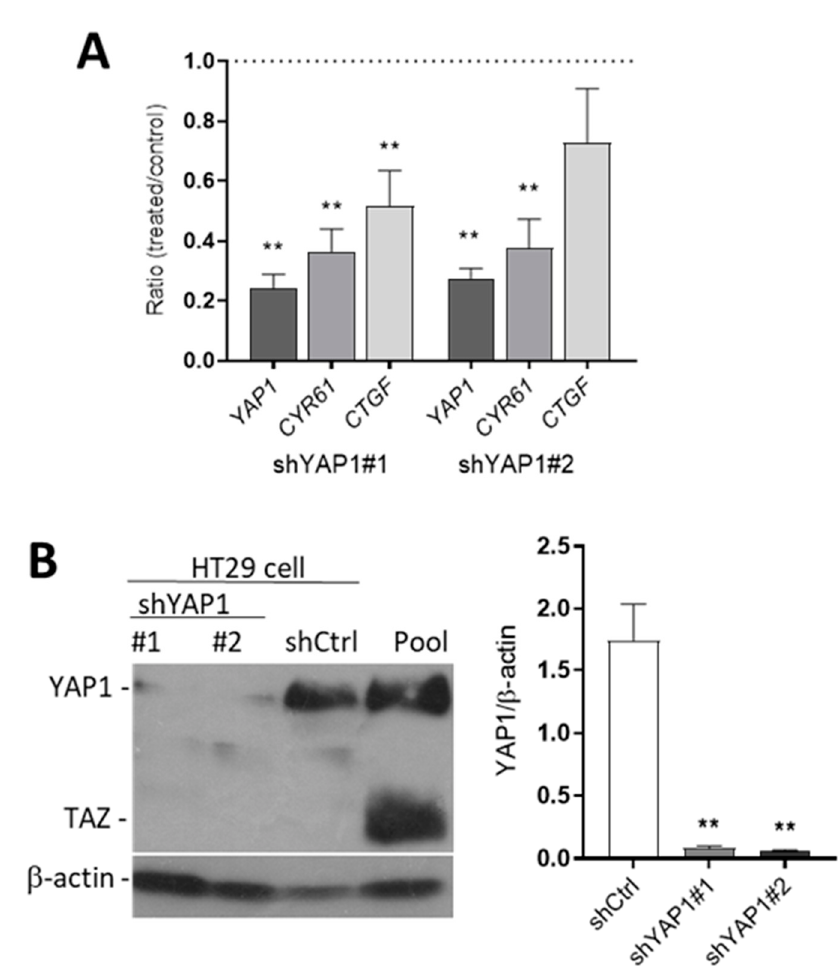
Figure 3. Efficiency of YAP1 knockdown in HT29 cells. ( A ) qPCR analyses were performed to detect the expression of YAP1 and two of its target genes CYR61 and CTGF in shYAP1 stably expressing cells using two specific sequences (identified as shYAP1 #1 and #2) relative to shCtrl. ( B ) Western blot analysis showing the expression of YAP1 protein in shYAP1#1, shYAP1#2 and shCtrl expressing cells. A cancer cell pool was used as reference for YAP1 and TAZ detection. β -actin was used as a loading control. ** p < 0.005.